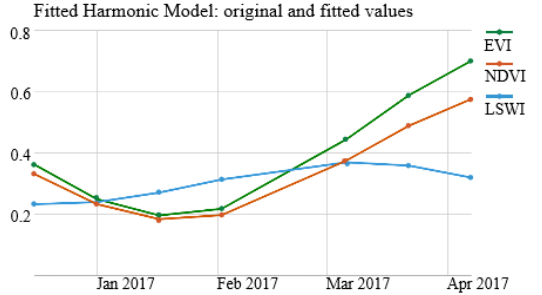
Figure 3. Landsat 8 fitted harmonic model for 2017 near Mymensingh.